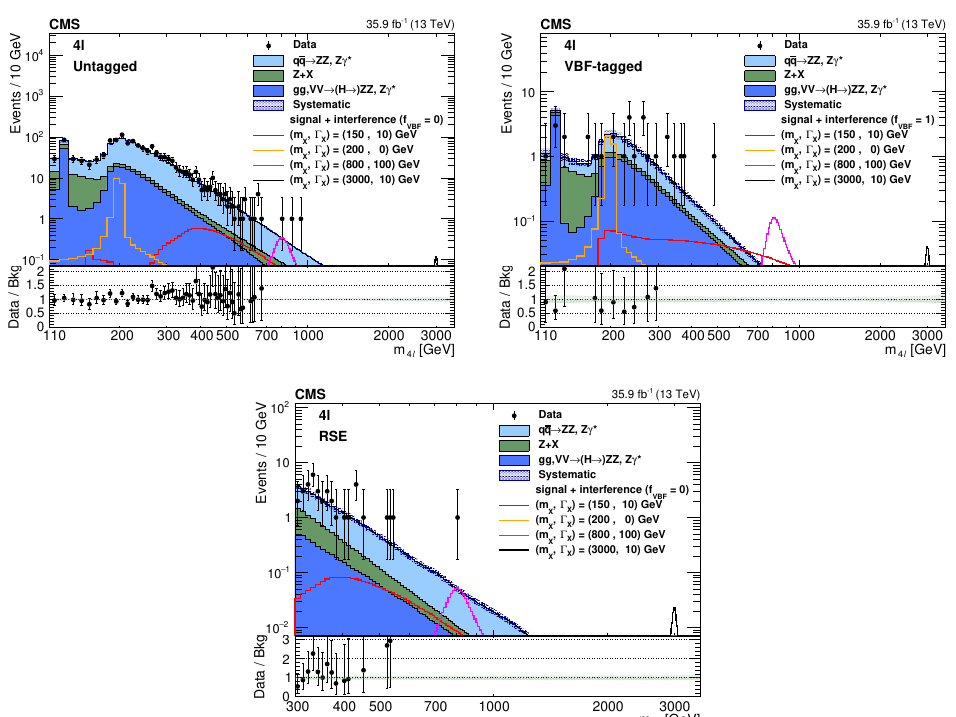
Figure 2 . Distributions of the four lepton invariant mass in the untagged (upper left plot), VBF- tagged (upper right plot) and RSE (lower plot) categories. Signal expectations including the inter- ference e(cid:11)ect for several mass and width hypotheses are shown. The signals are normalized to the expected upper limit of the cross section derived from this (cid:12)nal state. Lower panels show the ratio between data and background estimation in each